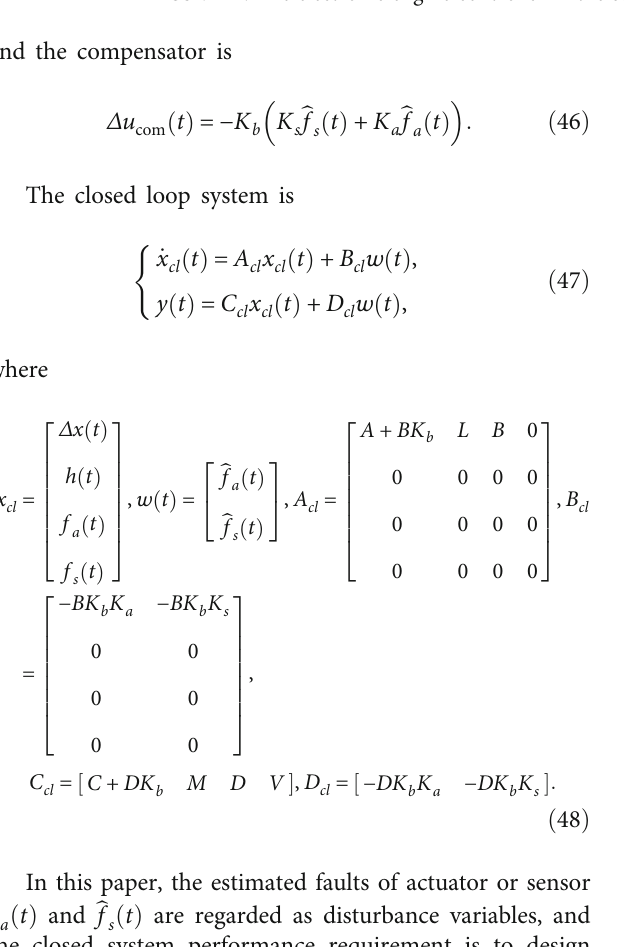
Figure 12: The electronic engine controller in the semiphysical platform (it is reproduced from [32]).